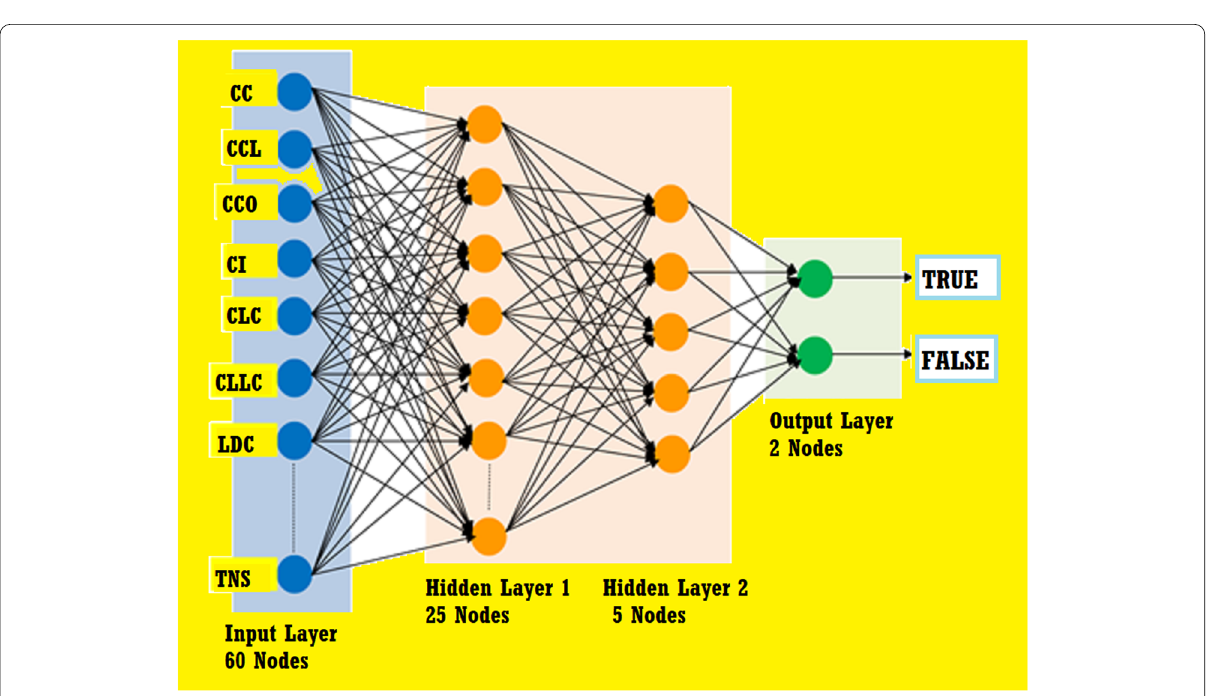
Fig. 10 Proposed architecture of MLP model for software defect